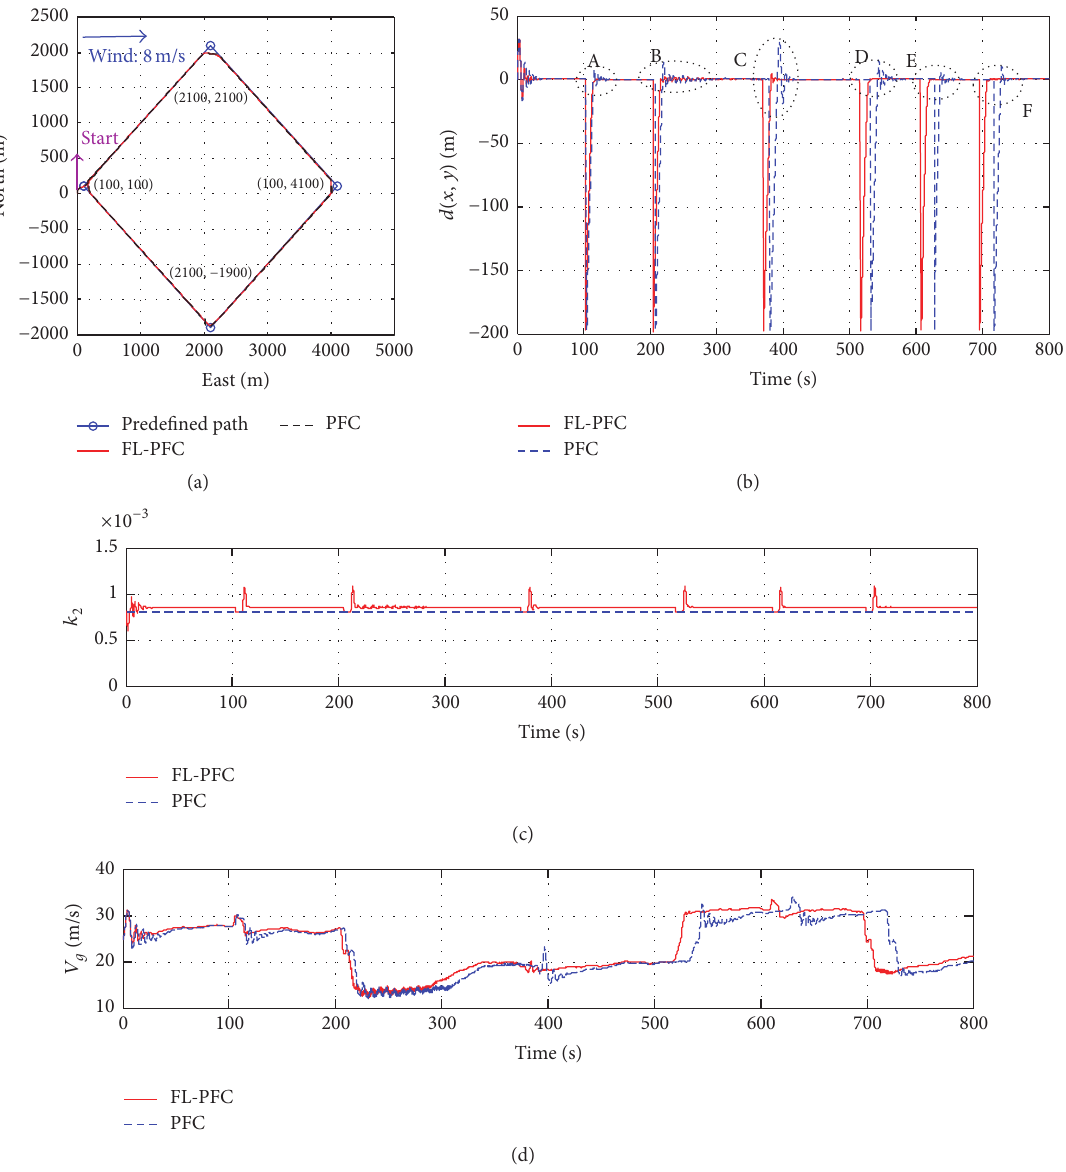
Figure 7: Comparison of the square path following with the methods FL_PFC and PFC. (a) The position compassion, (b) the distance 𝑑(𝑥,𝑦) compassion, (c) the parameter 𝑘 2 compassion, and (d) the inertial velocity 𝑉 𝑔